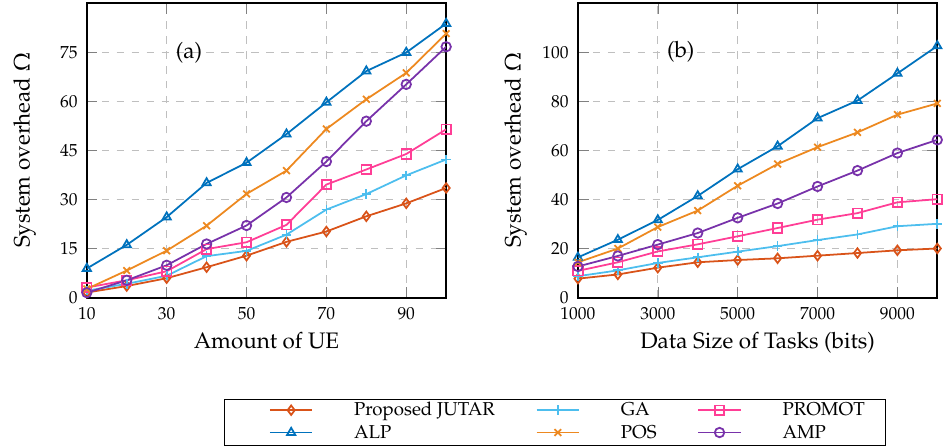
Figure 4. Comparison results of the system overhead vs. ( a ) amount of UE, ( b ) data size for the proposed JUTAR algorithm [8,10,18,19].